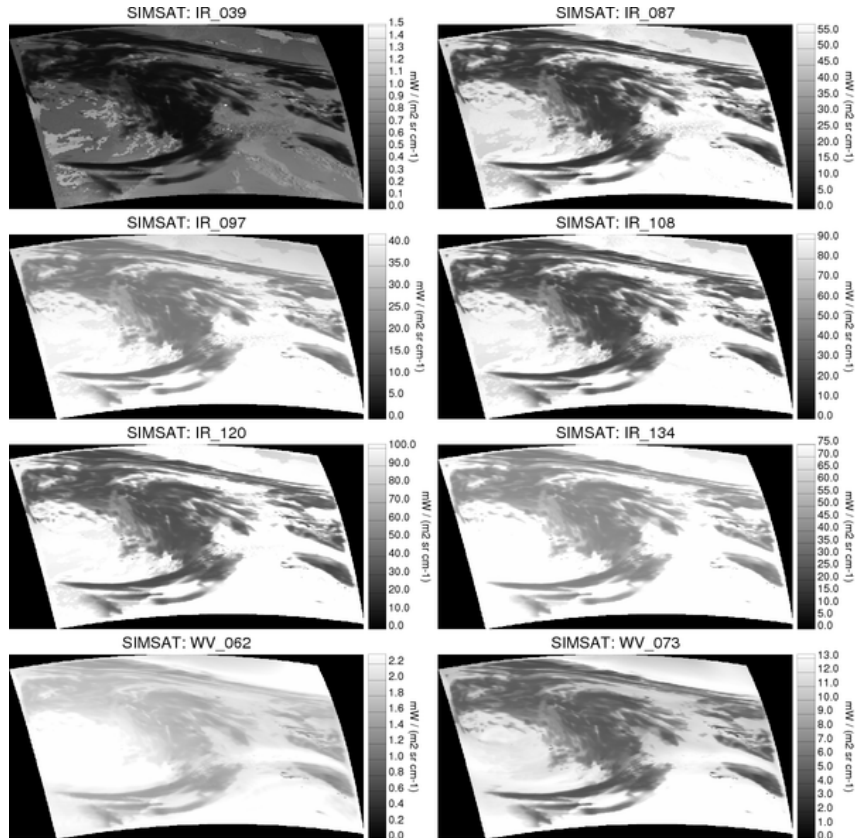
Fig. A2. Thermal SEVIRI radiances computed with libRadtran and projected onto the nominal MET-8/SEVIRI grid under consideration of the MET-8/SEVIRI point spread